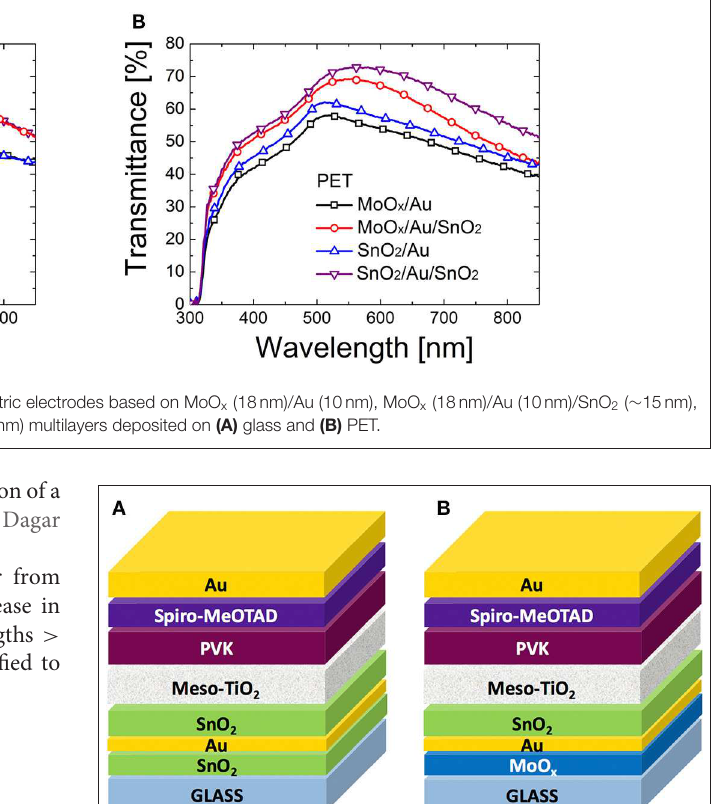
FIGURE 4 | Schematic representation of perovskite solar cells based on dielectric/metal/dielectric electrodes with (A) ∼ 25nm thick SnO 2 and (B) 18nm thick MoO x seed layers, thermally evaporated Au (10nm), and spin-coated SnO 2 of variable thickness; device stack was completed with a ∼ 250nm thick UV-treated mesoporous TiO 2 scaffold (meso-TiO 2 ), a CH 3 NH 3 PbI 3 perovskite active layer (PVK) infiltrated in the mesoporous TiO 2 and forming a ∼ 350nm thick overlayer on top of the scaffold, a spiro-MeOTAD hole transport layer ( ∼ 500nm) and a 90nm thick Au back